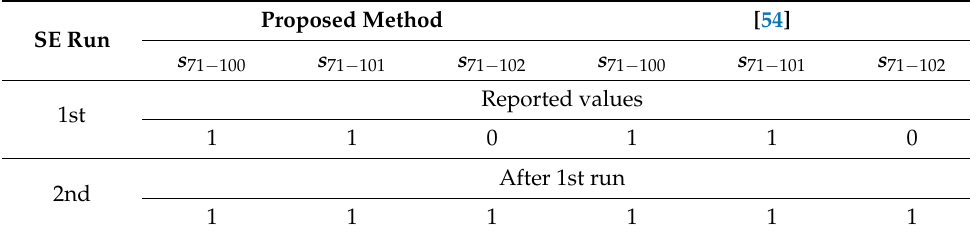
Table 9. Estimated status for each switching